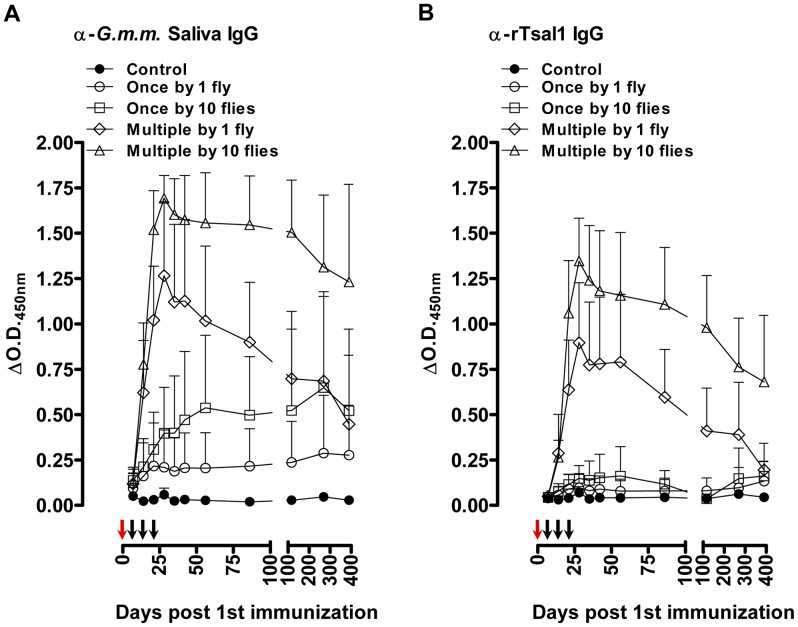
Tsetse fly induced humoral responses in mice.Long-term follow-up of (A) the anti-G. m. morsitans saliva IgG responses and (B) the anti-rTsal1 IgG responses in mice (n = 8/group) exposed to 4 different tsetse fly biting intensities (1 versus 10 flies) and frequencies (single versus weekly exposure for 3 weeks). Arrows indicate the tsetse exposure regimen for single exposed (red arrows) and multiple exposed mice (red and black arrows). Presented data are the mean ΔO.D.450 nm values and the 95% CI obtained with a 1∶1600 dilution of the individual plasmas.